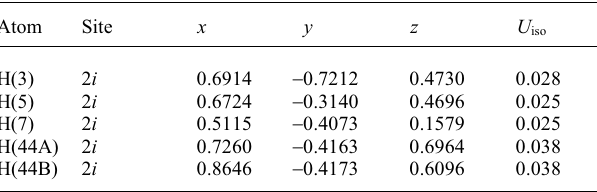
Table 2. Atomic coordinates and displacement parameters (in Å 2 )